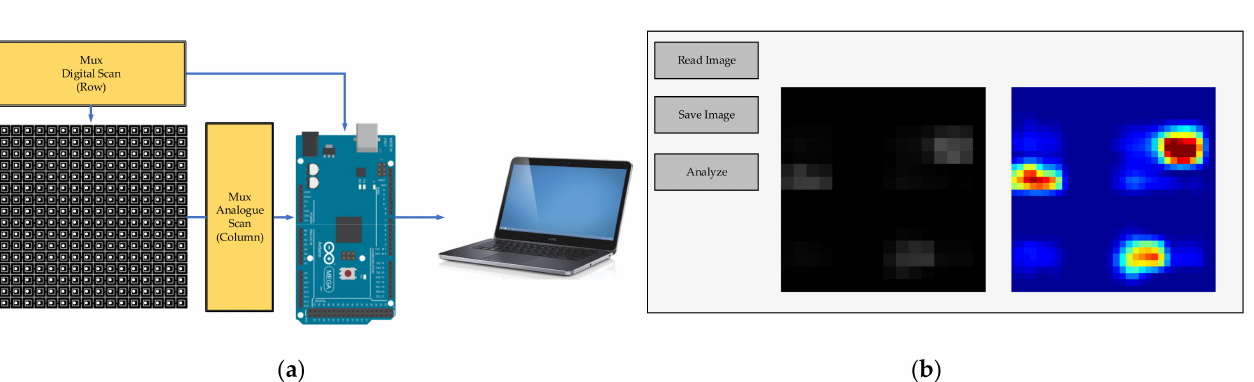
Figure 13. Tactile image acquisition system: ( a ) The schematic diagram of the tactile sensor array for image acquisition; ( b ) Image acquisition GUI.